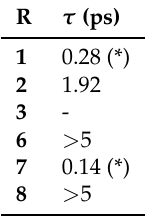
Table 4. Times ( τ ) required to transfer the excess proton in the water layer, due to α H extraction from C α , to O atoms either in the nitro group or in the carbonyl group (the latter case indicated with an